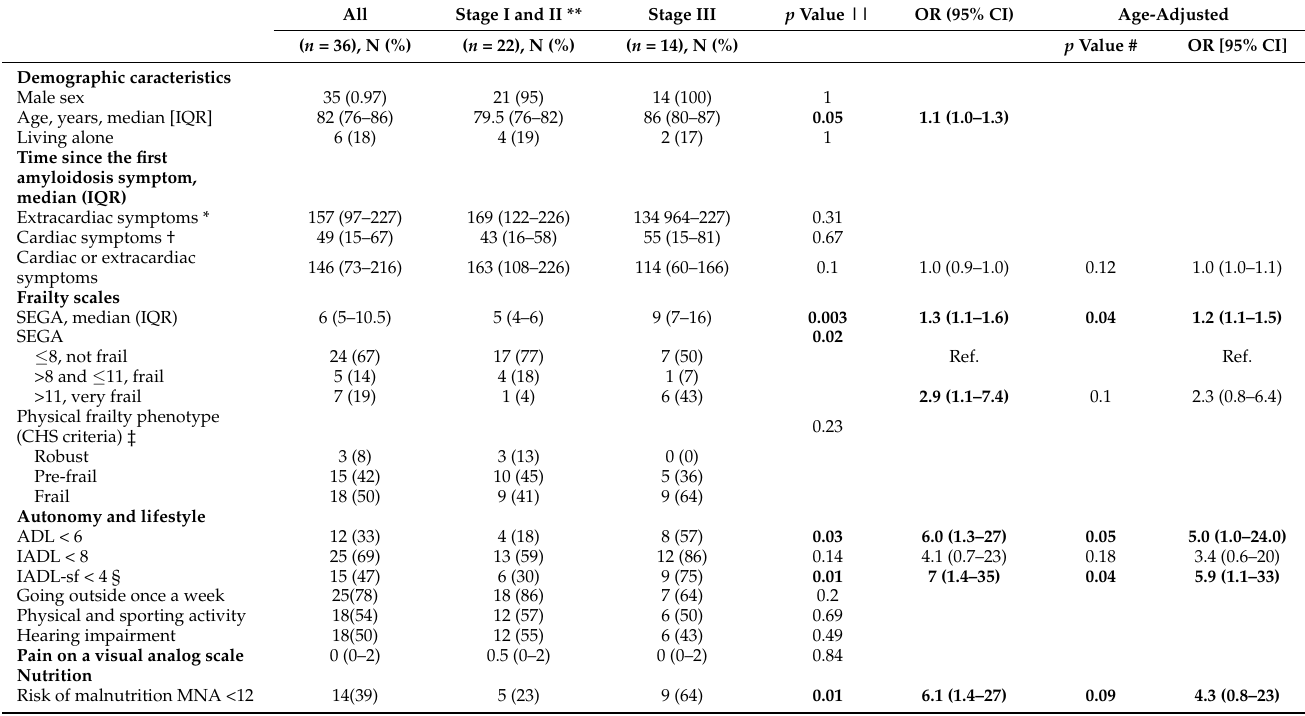
Figure 2. Frequency of frailty, and the relationships between frailty and organ impairment in patients with A-TTRwt-CA. The prevalence of frailty among patients with ATTRwt-CA can be explained by the amyloid fibril infiltration of various organs and tissues, particularly the heart, integumentary system, and nerves. FAB: frontal assessment battery, GDS: geriatric depression scale, IADL: instrumental activity of daily living, MNA: mini nutritional assessment, NYHA: New York heart association, SEGA: short emergency geriatric assessment SPPB: short physical performance battery, 7-CDT: 7-clock drawing test. Table 2. Frailty parameters, according to the Gillmore stage ( n =